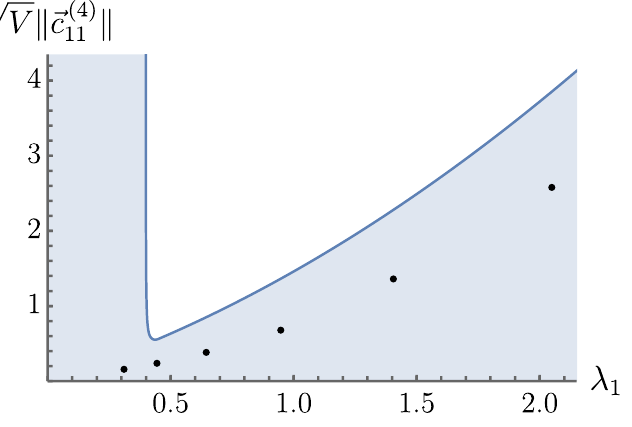
√ Figure 9 . An upper bound on V k ~c (4) k for closed hyperbolic surfaces. The filled circles correspond 11 to the genus-2 surfaces ρ ( ‘ ) , defined in eq. (4.16), for ‘ = 3 , . . . , 8 , going from right to